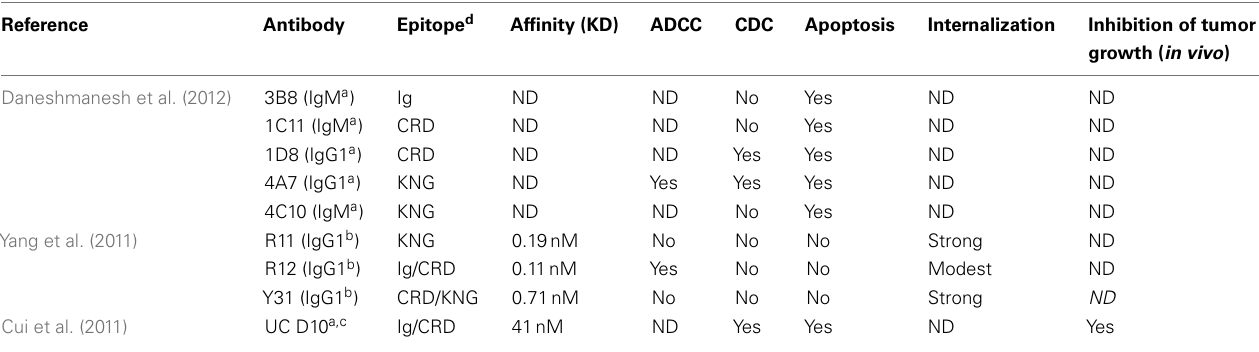
a Mouse antibody. b Rabbit/human chimeric IgG1 antibody. c Target cells for biological activity includes ROR1-positive leukemia cell lines, in addition to primary CLL cells. d Refer to Figure 1 for domain